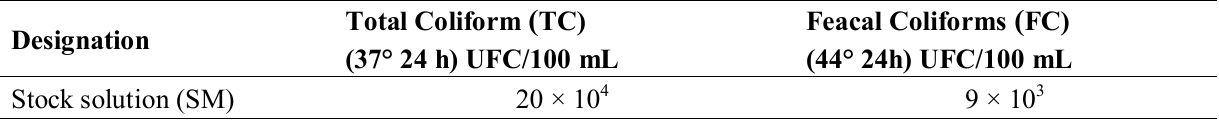
Table 3. Treated wastewater bacteriological load for disinfection tests.